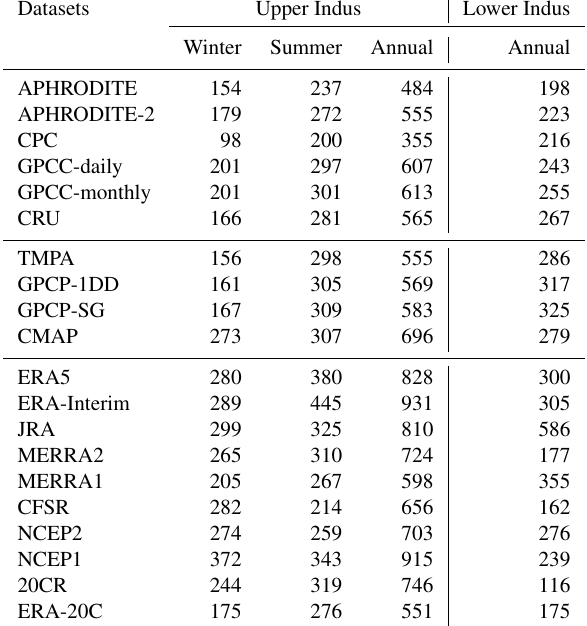
Table 4. Mean annual and seasonal precipitation (in mm) falling over the two study areas, for the period 1998–2007. Winter is de- fined from December to March and summer from June to Septem- ber. The first 10 datasets are observations, the second 10 are reanal-